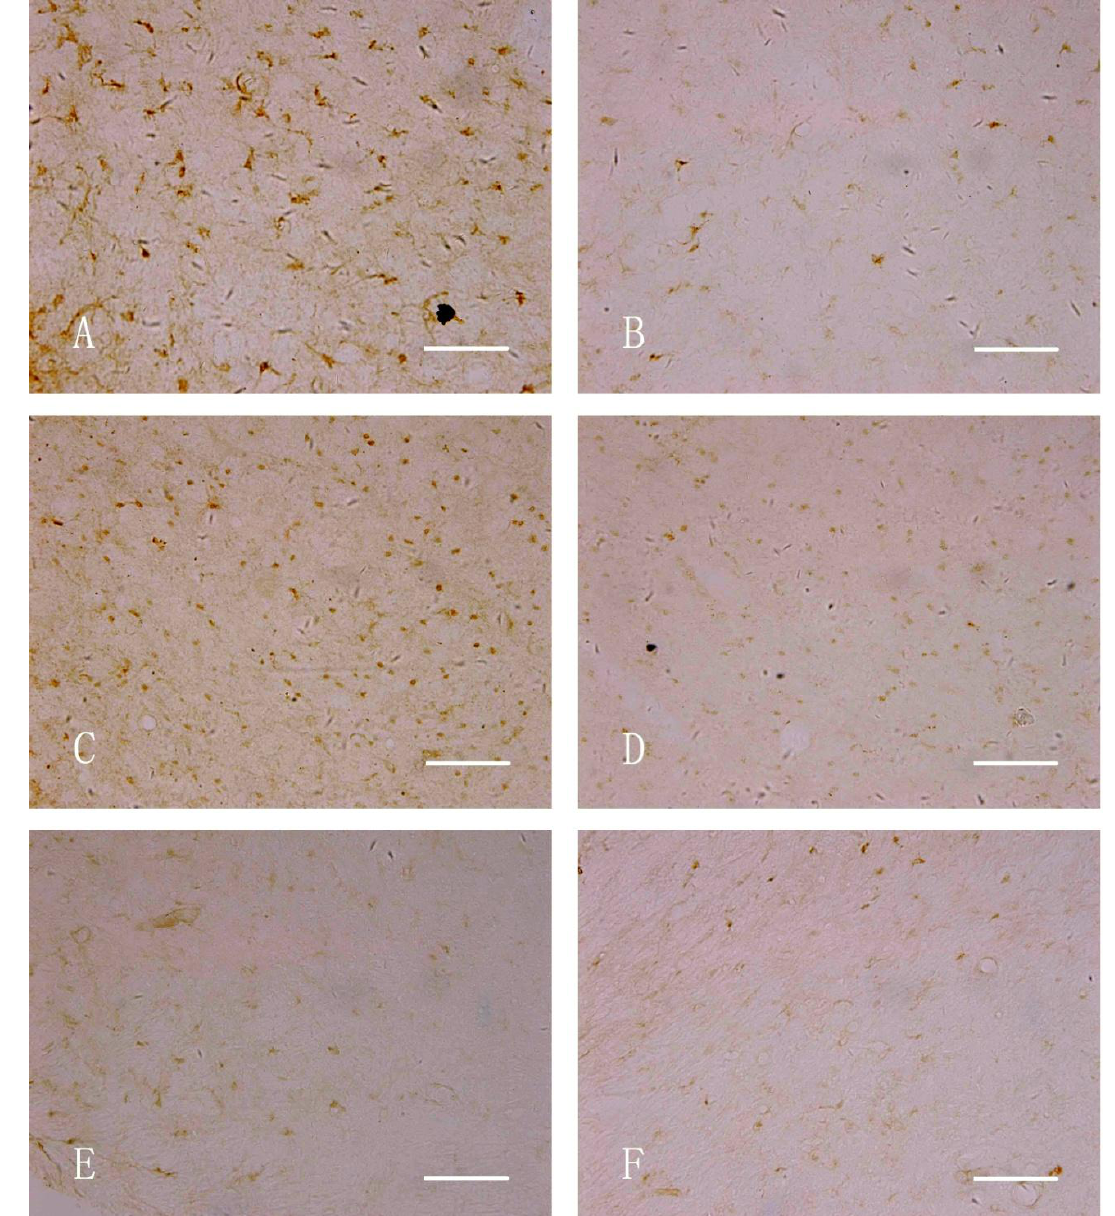
Figure 3. iNOS immunohistochemical staining of the midbrain of rats (400×, Bar = 50 μm). ( A ) Damaged side, nano-MnO group; ( B ) uninjured side, nano-MnO 2 ( C ) damaged side, 6-OHDA group; ( D ) uninjured side, 6-OHDA group; ( E ) damaged side, saline group; and ( F ) uninjured side, saline